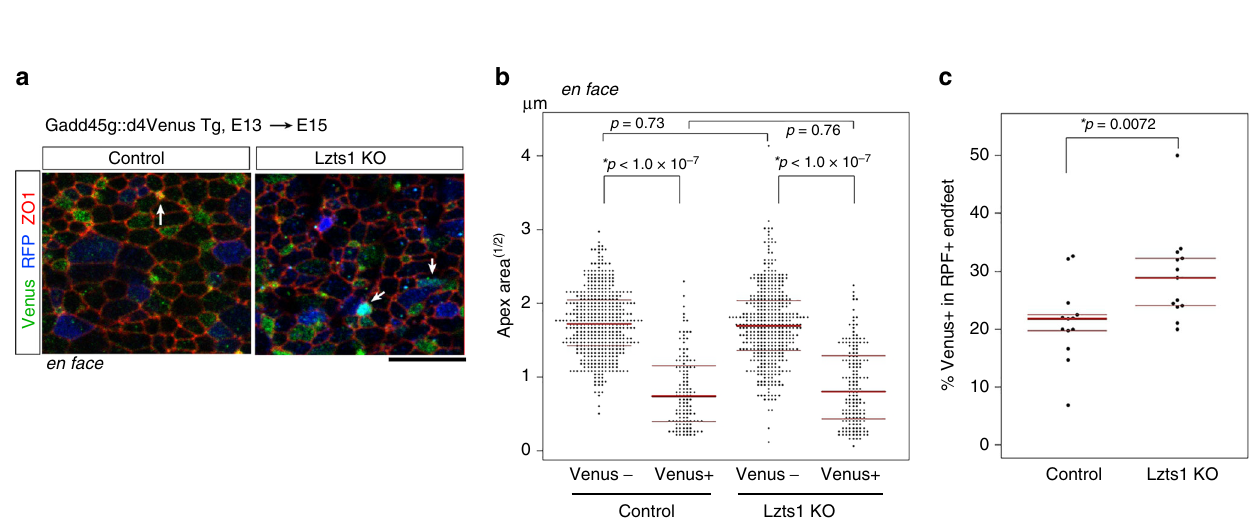
Fig. 4 Lzts1 is dispensable for apical contraction but ensures rapid delamination. a – c CRISPR/Cas9-mediated Lzts1 KO was performed by electroporating the plasmids into E13 Gadd45g::d4Venus Tg mice in vivo, and the apical endfeet were examined at E15 by performing en face observations. a Arrows indicate the RFP + (electroporated) cells that are Venus + (neuronally differentiating). b Lzts1 KO did not change the distribution of the circumferential length of AJ rings in both Venus + and Venus − cell populations. N = 445, 124, 404, and 162 cells from fi ve (control) and six (KO) embryos, respectively, Steel – Dwass test. c Lzts1 KO increased the percentage of Venus + apical endfeet among RFP + endfeet. N = 13 and 13 fi elds from six embryos per experiment, Wilcoxson rank sum test. Bar, 5 μ m. Medians with Q1 and Q3 values are reported. Source data are provided as a Source Data fi le